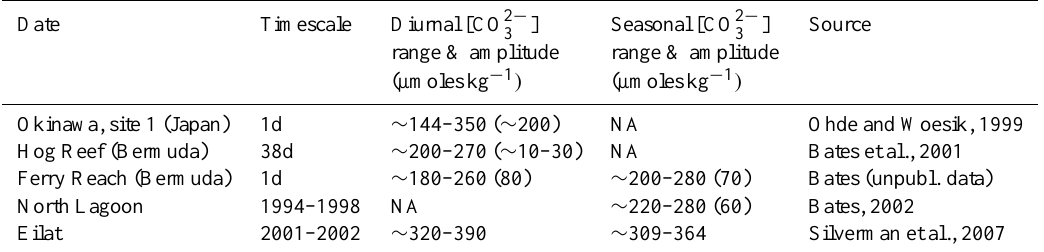
Table 1. Natural seawater [CO 2 − ] variability observed at coral reef sites. Diurnal and seasonal [CO 2 − 3 alkalinity and pH observed on the Eilat coral reef by Silverman et al.,